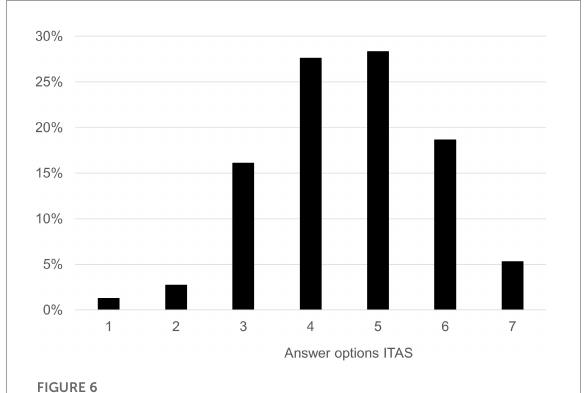
FIGURE6 Percentage distribution of sample 2 responses given across the 7-level